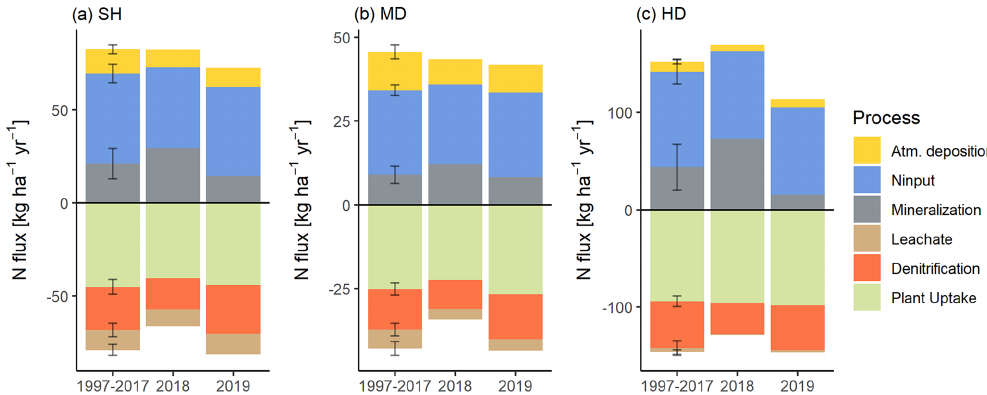
Figure 4. N input and N fluxes simulated via mHM-SAS separately for the three Selke sub-catchments (SH, MD, and HD). N entering the catchment soils are shown as positive values, N fluxes leaving the catchment soils are shown as negative values. Error bars represent the standard deviation between annual averages from 1997 to